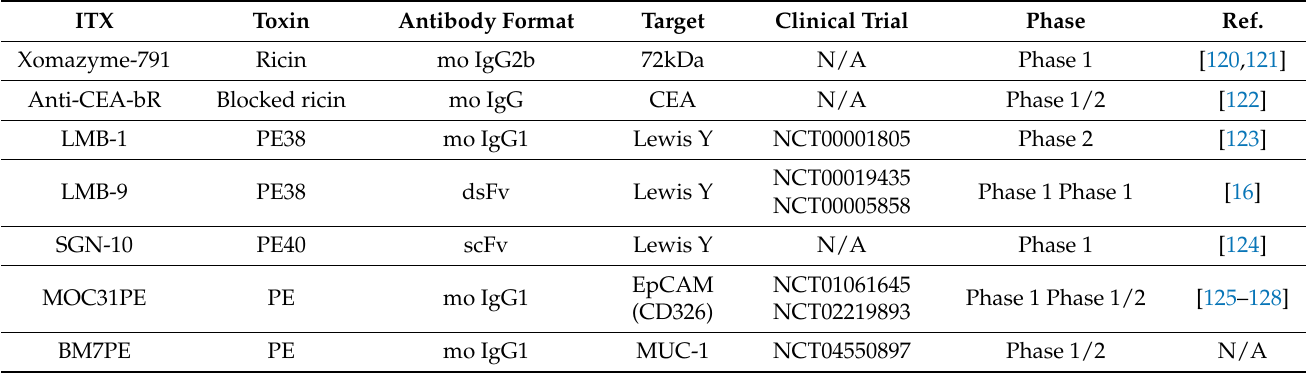
Table 1. Immunotoxins tested in colorectal cancer